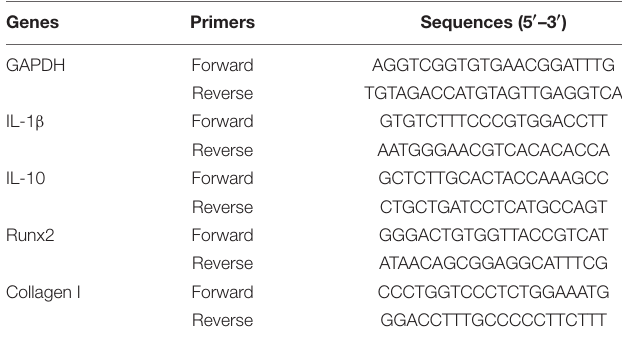
TABLE 1 | List of primers used in this study for